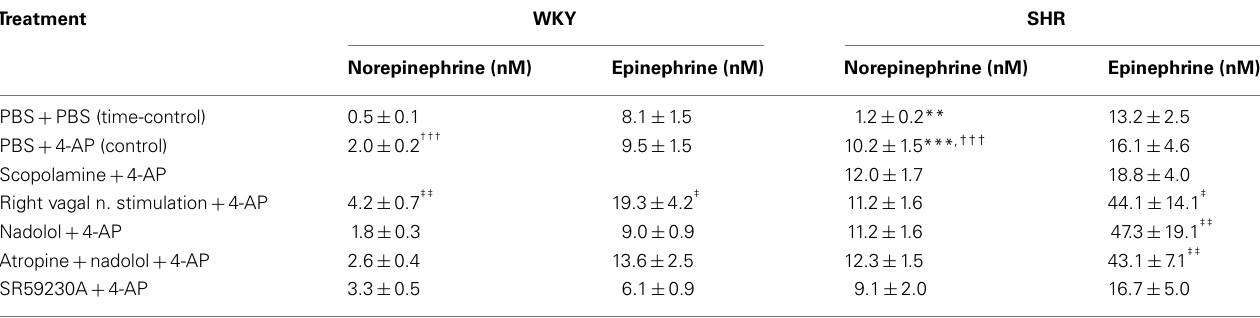
Table 3 |The effect of 4-AP on plasma catecholamine